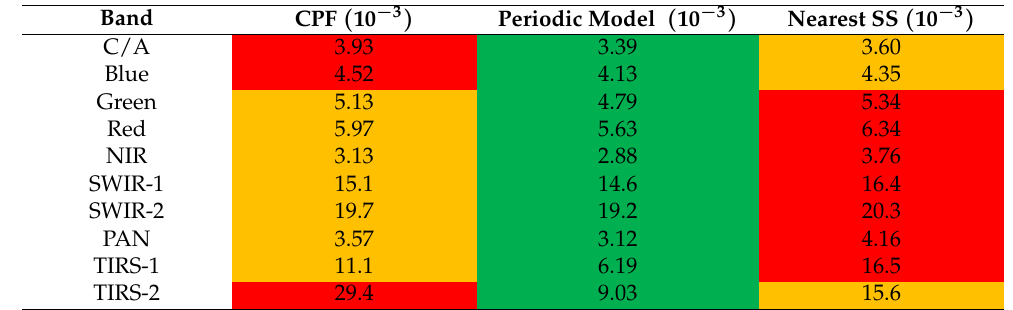
Table 7. Summary of average Overlap Detector Metric for all scene sets from the three FPM gain correction methods; red data is statistically the worst, followed by yellow data, and green data is statistically the best; if multiple cells are the same color that data is statistically the same, as proven by the t -test. In-scene metrics are not shown as their value would be 0 due to being derived from the scene itself.